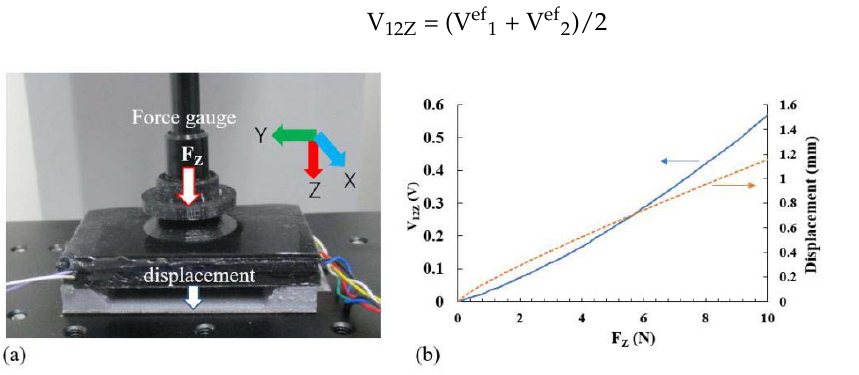
Figure 6. Measurement of normal force F Z : ( a ) photograph, ( b ) relationship between F Z and V 12Z or displacement.